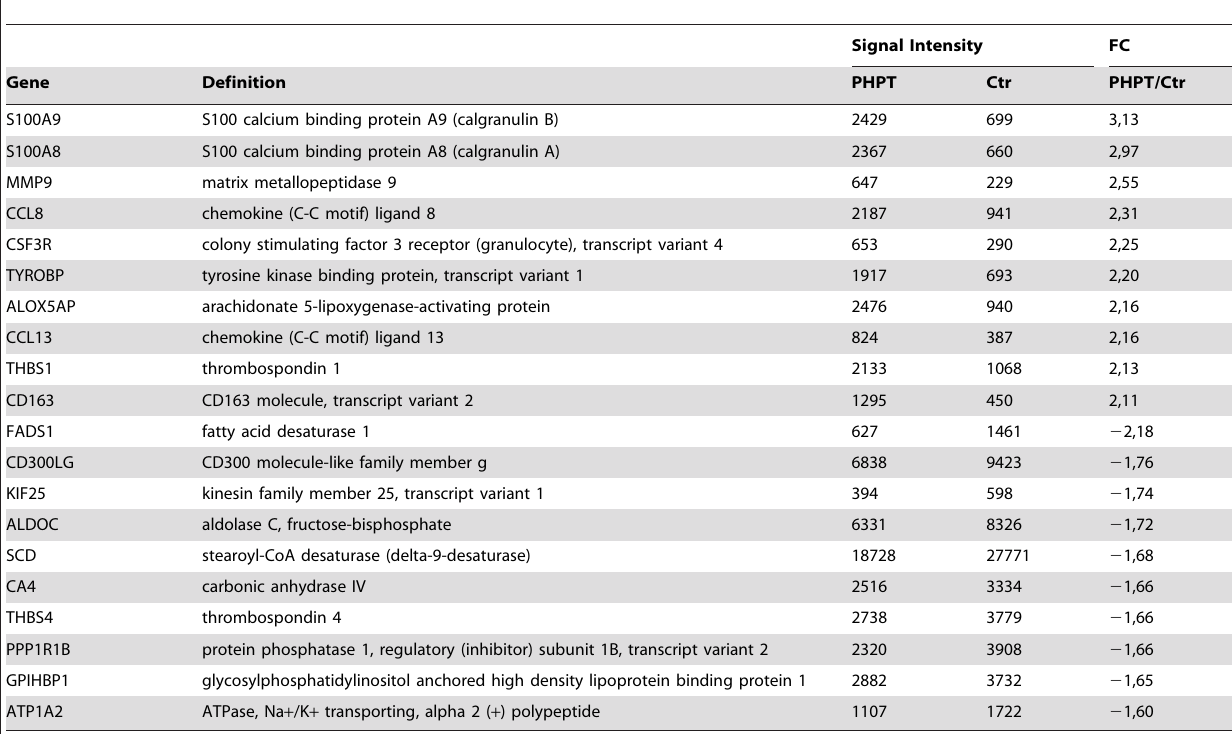
Table 3. Top 10 up-regulated and down-regulated genes in patients with PHPT compared to controls, based on Significance Analysis of Microarrays (SAM-analysis) (q-value ,